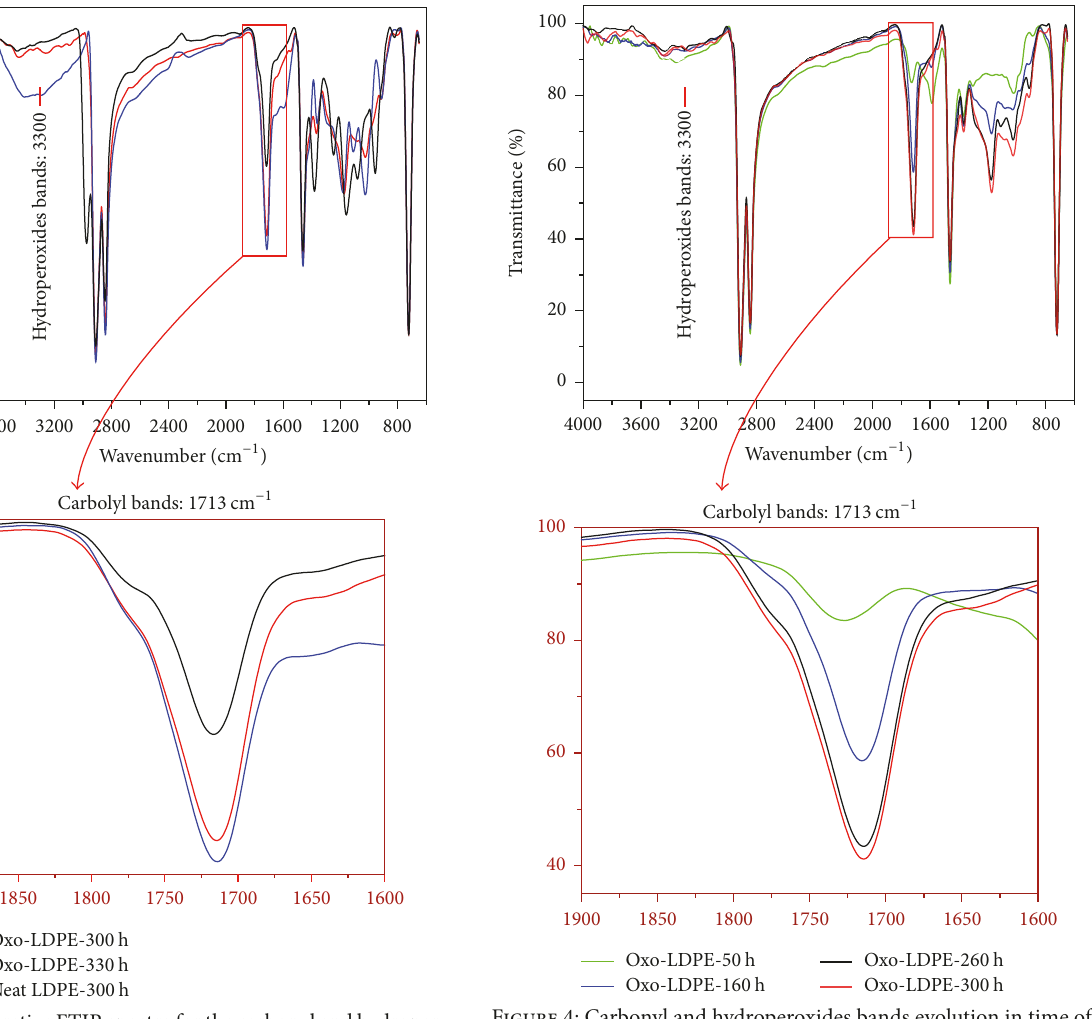
Figure 3: Comparative FTIR spectra for the carbonyl and hydroper- oxides bands evolution in time for oxo-degradable LDPE and LDPE exposed in a Xenon arc chamber.